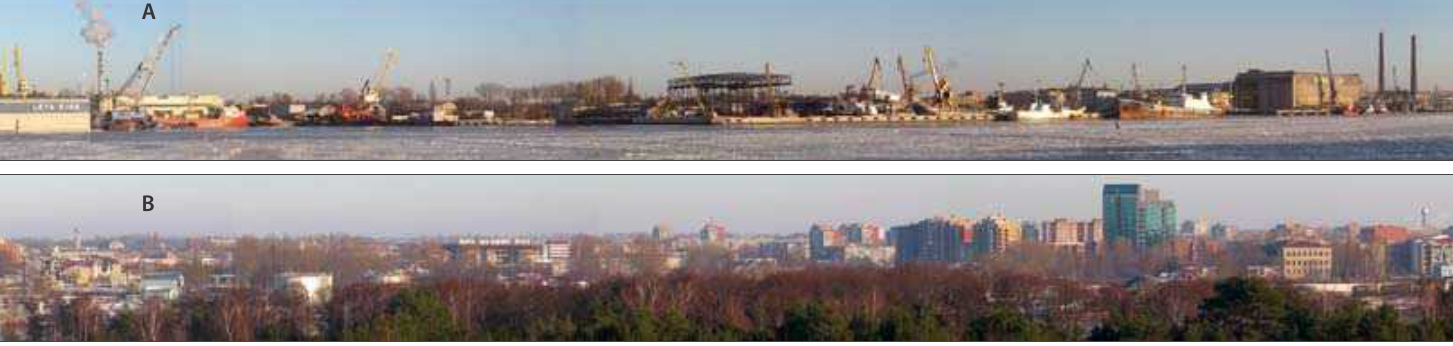
Fig. 9. Fragments of view points “from inside to outside” from the Curonian Spit: A – to the first ferry; b – to the second ferry